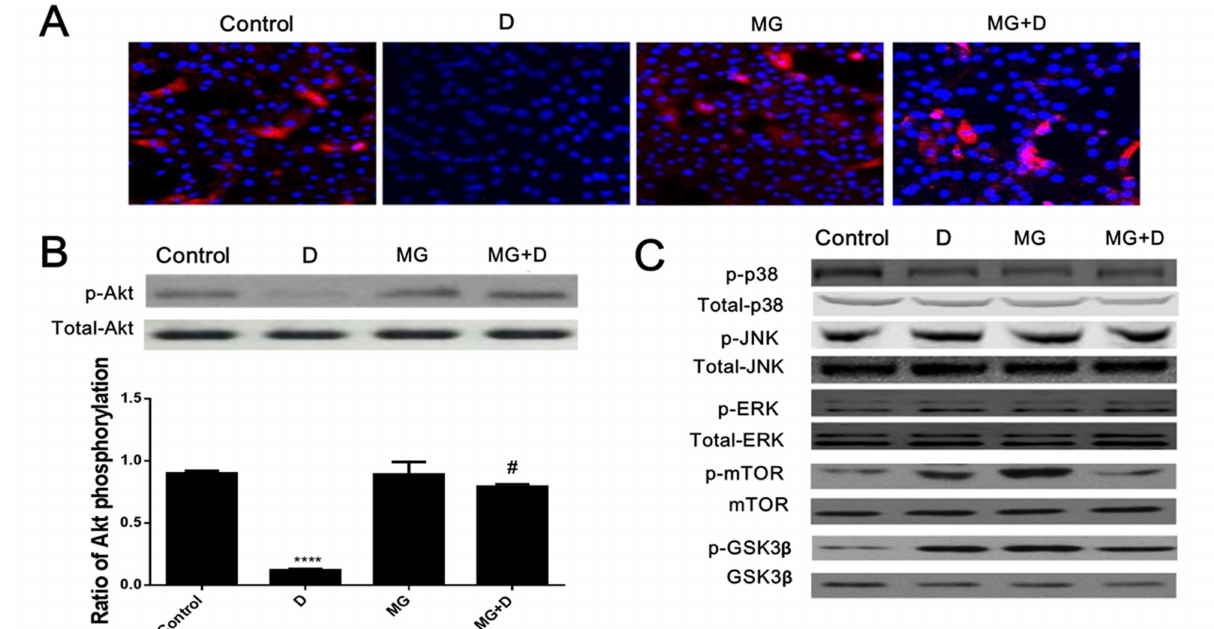
Fig 5. Akt phosphorylation was involved in the protective effect of GB in DOX induced cardiotoxicity. ( A ) Immunofluorescence analysisof Akt phosphorylation. Decreased Akt phosphorylation was found after DOX treatment but pretreatment with GB restored this effect. ( B ) Western-blot analysisof Akt phosphorylation. Significantly decreased Akt phosphorylation was found after DOX treatment but GB treatment significantly activated the Akt phosphorylation. ( C ) Phosphorylation of p38, JNK, Erk, mTOR and GSK3 β was not involvedin the protective effect of GB in DOX inducedcardiotoxicity. No significantdifference was found on p38, p-JNK, p-Erk, p-mTOR and p-GSK3 β as detected by western-blot analysis. **** p < 0.0001whencomparedto control group, #p < 0.0001when comparedto